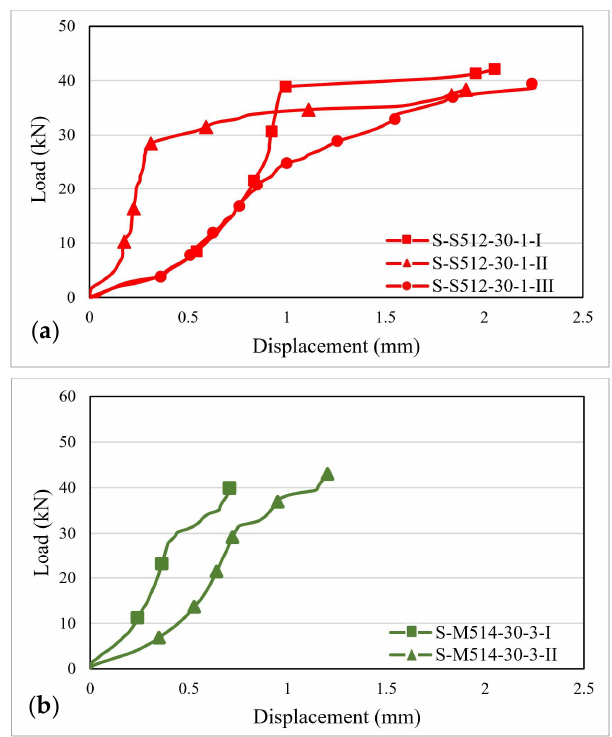
Figure 7. Load–displacement curves for: ( a ) S-S512-30-1 and ( b ) S-M514-30-3 specimens.